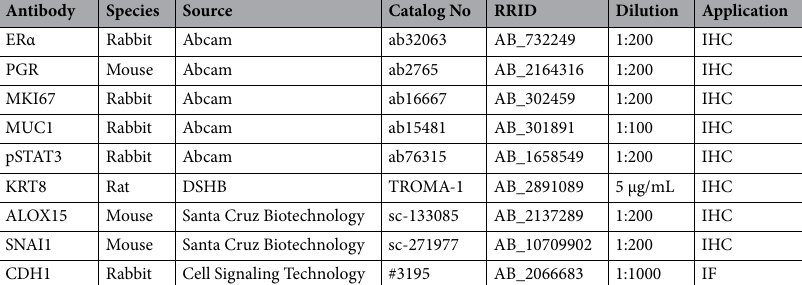
Table 1. Primary antibody list. IHC immunohistochemistry, IF